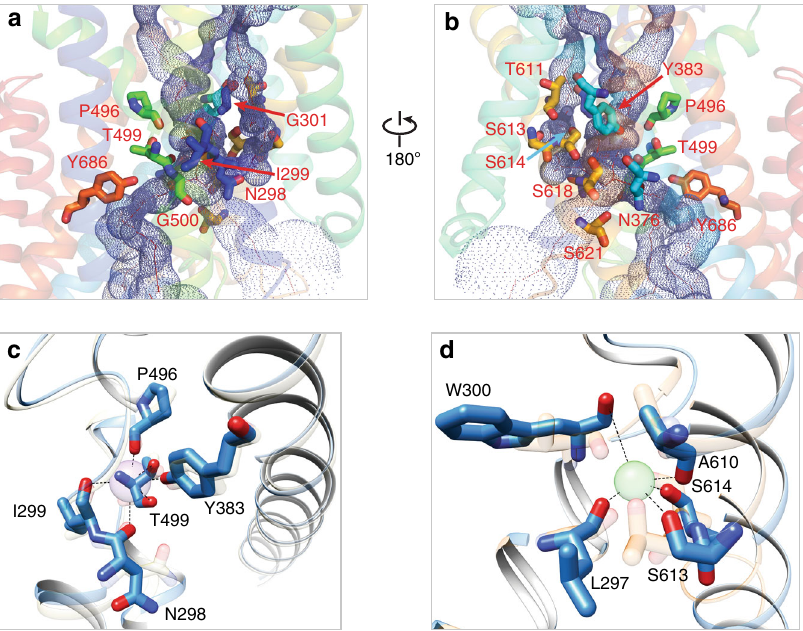
Fig. 4 Central ion binding sites in human NKCC1. a , b Residues directly involved in ion coordination and hydrophilic residues residing in close proximity to ion binding sites are shown in sticks. c Comparison of human and Danio rerio NKCC1 K + binding site. K + coordinating residues are shown in sticks. K + (sphere) and equivalent residues in Danio rerio NKCC1 are rendered as semi-transparent sticks. d Comparison of the putative human NKCC1 Na + site with the Na + site 2 in LeuT. Na + coordinating residues in NKCC1 are shown as sticks. Na + (sphere) and equivalent residues in LeuT are rendered as semi- transparent